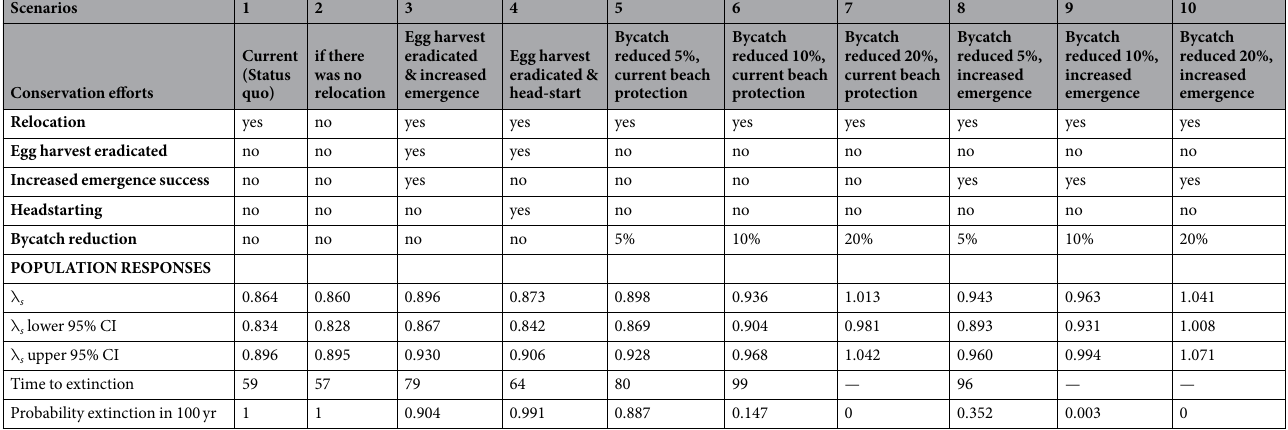
Table 2. Scenarios considered modifying adult/subadult and juvenile survivals and breeding propensities to simulate bycatch reduction. Responses were measured as stochastic population growth rate ( λ s ), time to extinction and probability of extinction in 100